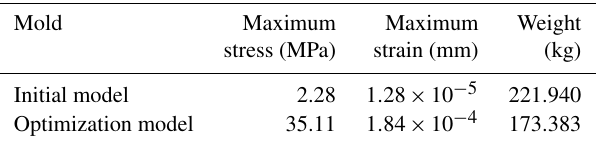
Table 6. Comparison of the structure and performance of the new manipulator forearm model and the original